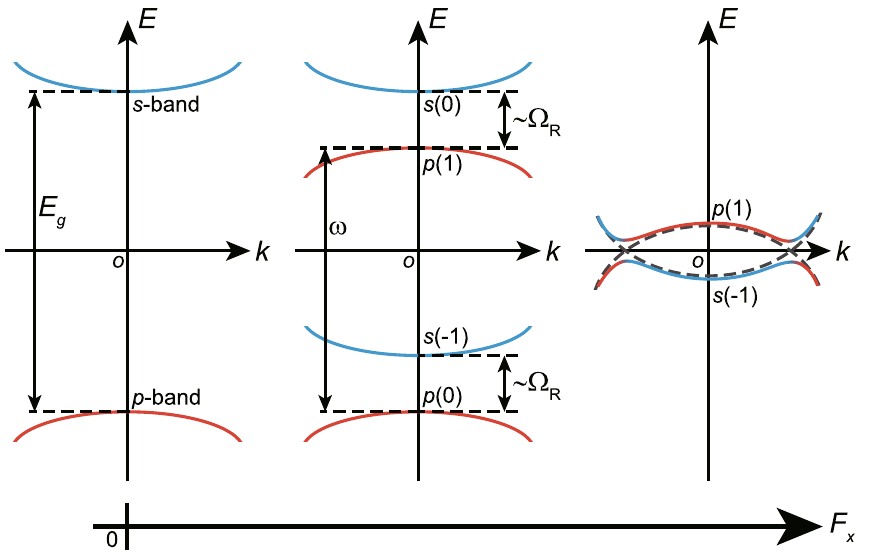
Figure 1. Scheme of the nearly resonant optical-excitation followed by the OSE. (Left) The original energy allocation of the p -band (red solid line) and the s -band (blue solid line) with energy gap E g . (Center) With the application of cw-laser with frequency ω and constant electric field F x , the OSE causes quasienergy-splitting of the order of the Rabi frequency (cid:31) R between a pair of photodressed bands, s ( n − 1 ) and p ( n ), with n = 0, 1 . (Right) With the further increase in F x , a pair of bands of p (1) and s ( − 1 ) undergoes inversion with anticrossing. Band crossing takes place at a certain F x , as shown by a dashed